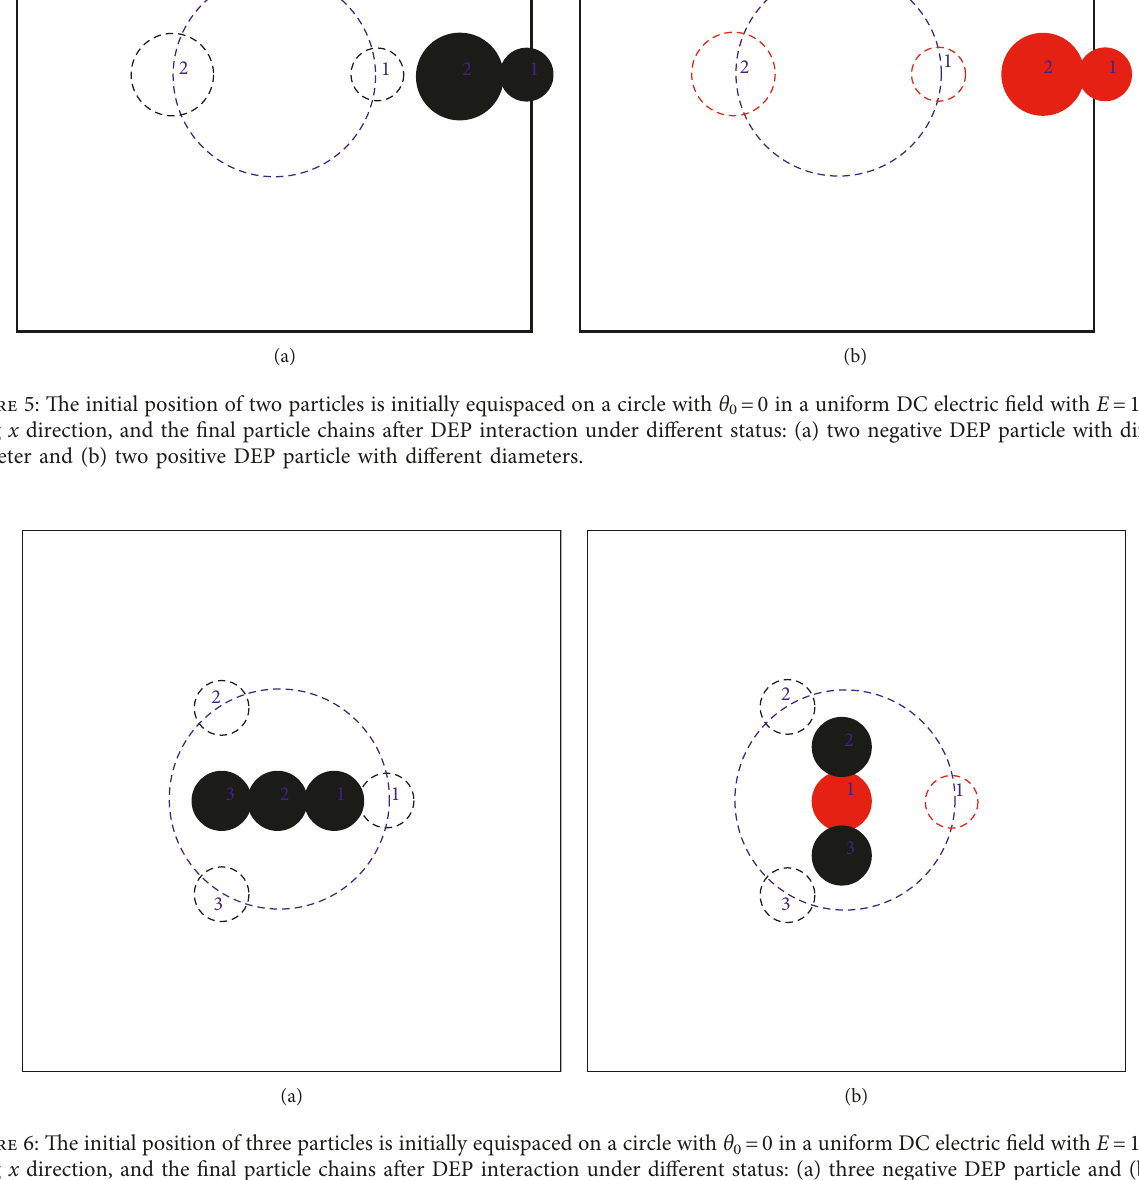
0 (cid:31) 0 in a uniform DC electric field with E (cid:31) 1kV/m